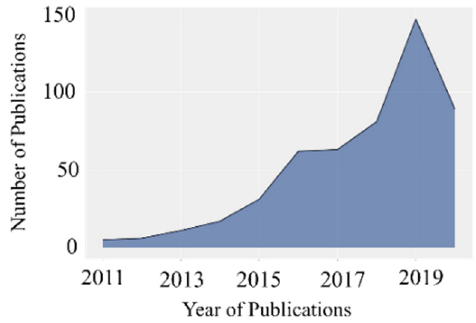
Figure 6. Annual Scientific Production (LCOE).